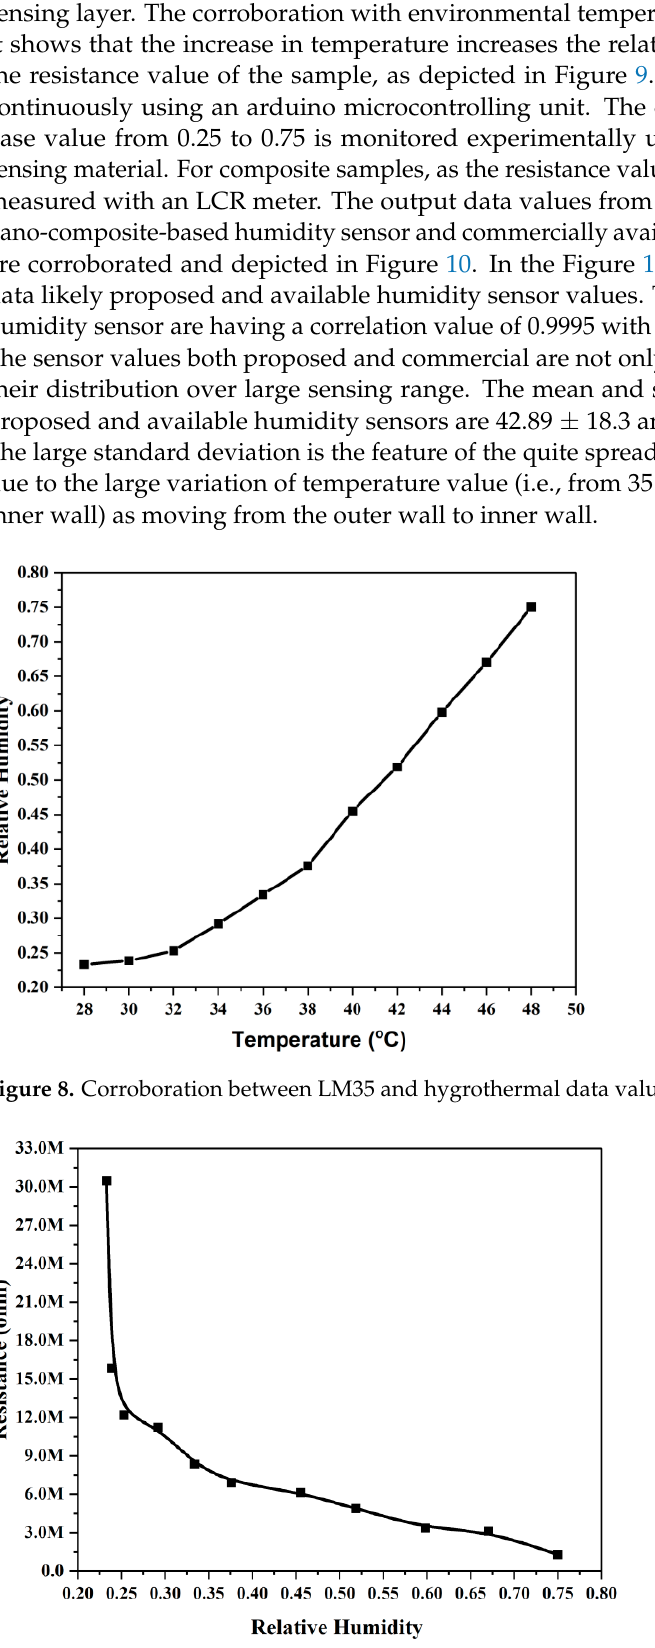
Figure 9. Environmental relative humidity vs. resistance of the FA–ZnO sensing